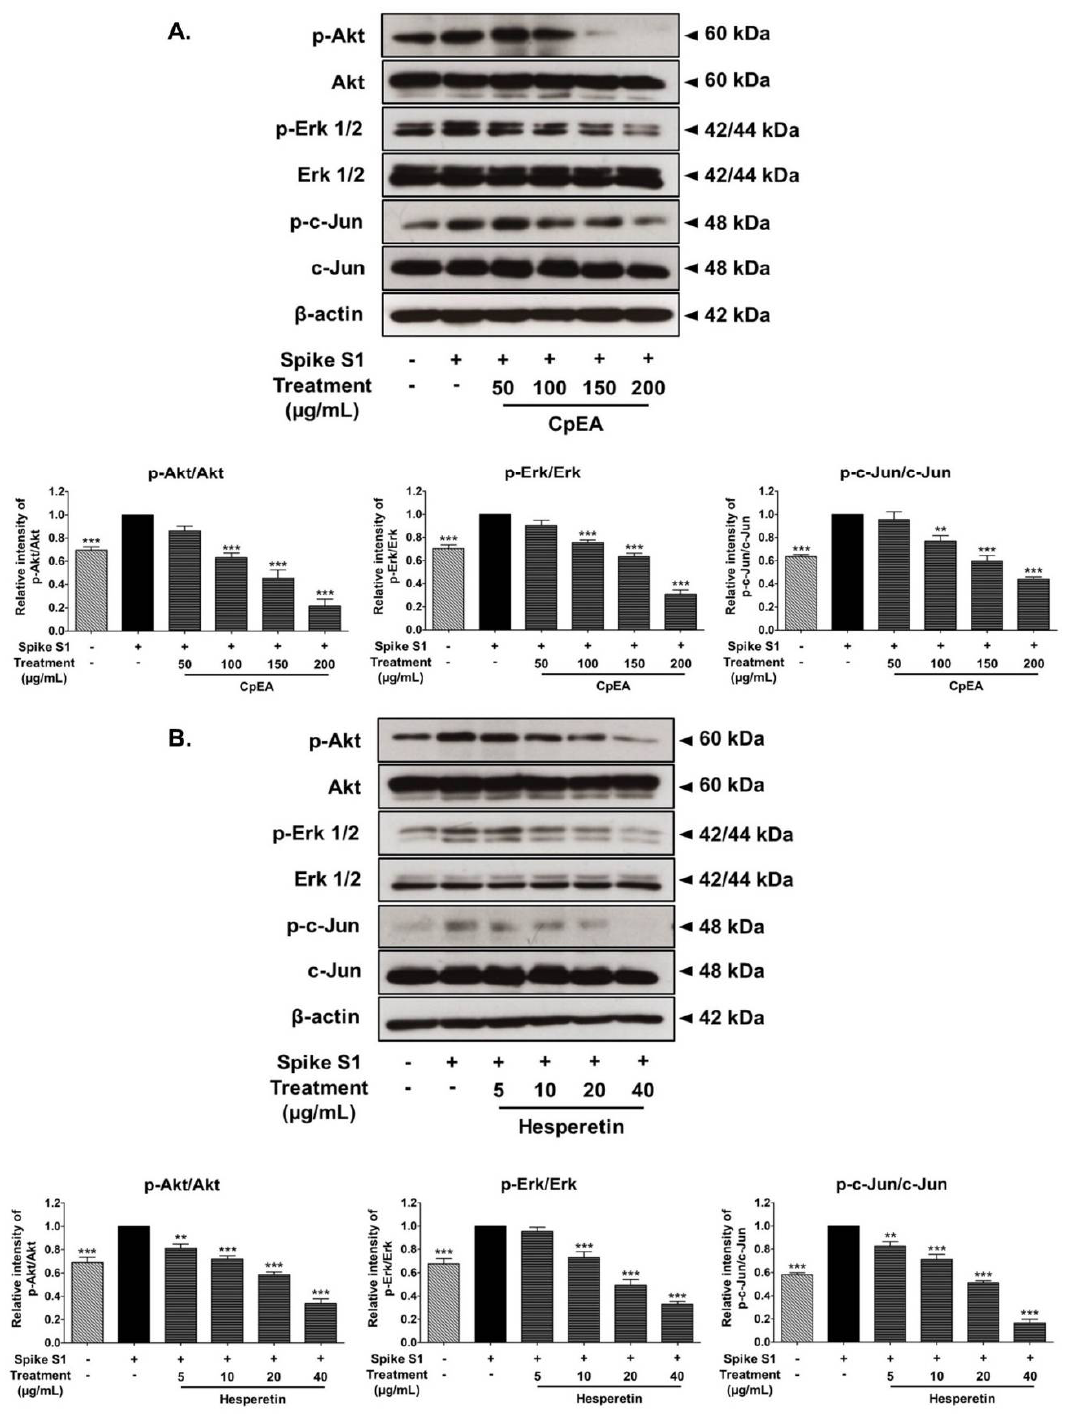
Figure 6. CpEA and hesperetin inactivated the Akt/Erk/c-Jun signaling pathway in Spike-S1- induced A549 cells. A549 lung cells were pre-treated with CpEA at a concentration of 0–200 μg/mL or hesperetin at a concentration of 0–40 μg/mL for 24 h, and then exposed to Spike S1 for 3 h. The inhibitory effects of CpEA ( A ) and hesperetin ( B ) on the phosphorylation of Akt, Erk1/2, and c-Jun proteins in A549 cells were displayed in Western blot and band density measurements. The Spike S1-induced A549 cells are presented as 100% of control. Data are presented as mean ± S.D. values of three independent experiments, ** p < 0.01 and *** p < 0.001 vs. the Spike S1-induced A549 cells.